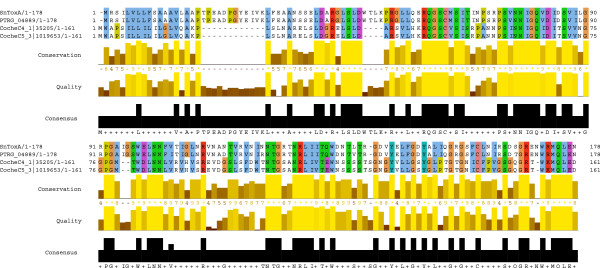
HMM search returns ToxA-like proteins in Cochliobolus heterostrophus isolates C4 and C5. A phmmer search with SnToxA (SNOG_16571) returns sequence similarity hits to Pyrenophora tritici-repentis (PTRG_04889) and hits to potential ToxA-like domains in two proteins in Cochliobolus heterostrophus isolates C4 and C5. The corresponding multiple alignment of the phmmer domain hits is visualized by Jalview [39].